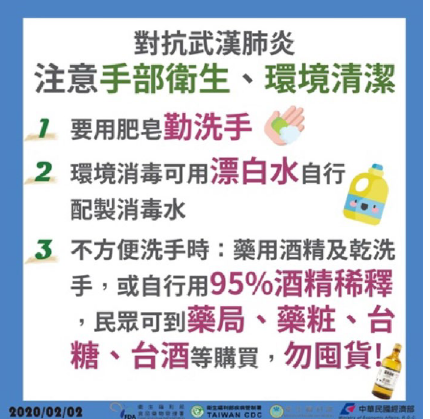
Figure 1. Promotional materials from the Ministry of Health and Welfare. Note: Translation: “Counteracting the Wuhan Virus: Pay attention to hand hygiene and environmental cleanliness. 1. Wash your hands frequently with soap. 2. Disinfect your surroundings with bleach. 3. When it is inconvenient to wash your hands, dry wash your hands with medicinal alcohol or use a 95% alcohol solution available in pharmacies, Taiwan Sugar, or TTL to dilute. Don’t